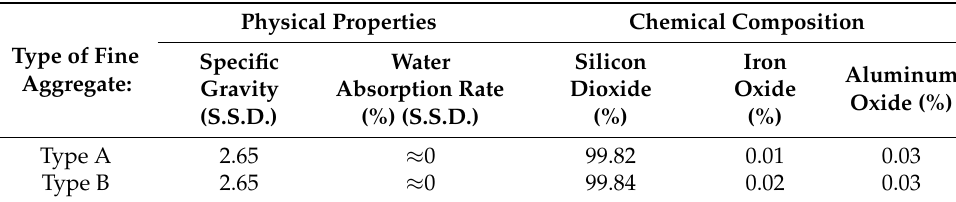
Figure 1. The appearance of the fibers: ( a ) steel fibers and ( b ) polypropylene fibers. Table 1. The properties and compositions of the fine aggregates. Table 3. The physical and mechanical properties of the fibers.